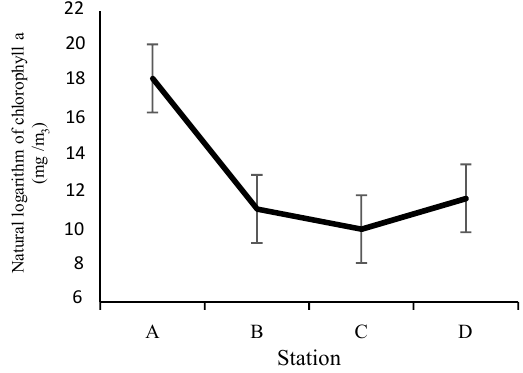
Fig. 2. Mean content of chlorophyll-a (mg/m 3 ) in various stations in Choghakhor wetland